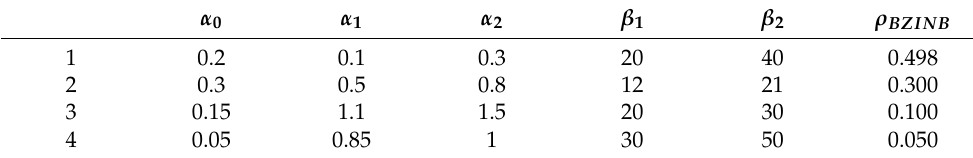
Table A1. Shape and scale parameters used to obtain various values of correlation for BZINB simulation for vector pairs that represent pairs of metabolites and species. The number labels of each line denote the parameters used to obtain results for each line of Appendix A Table A3.